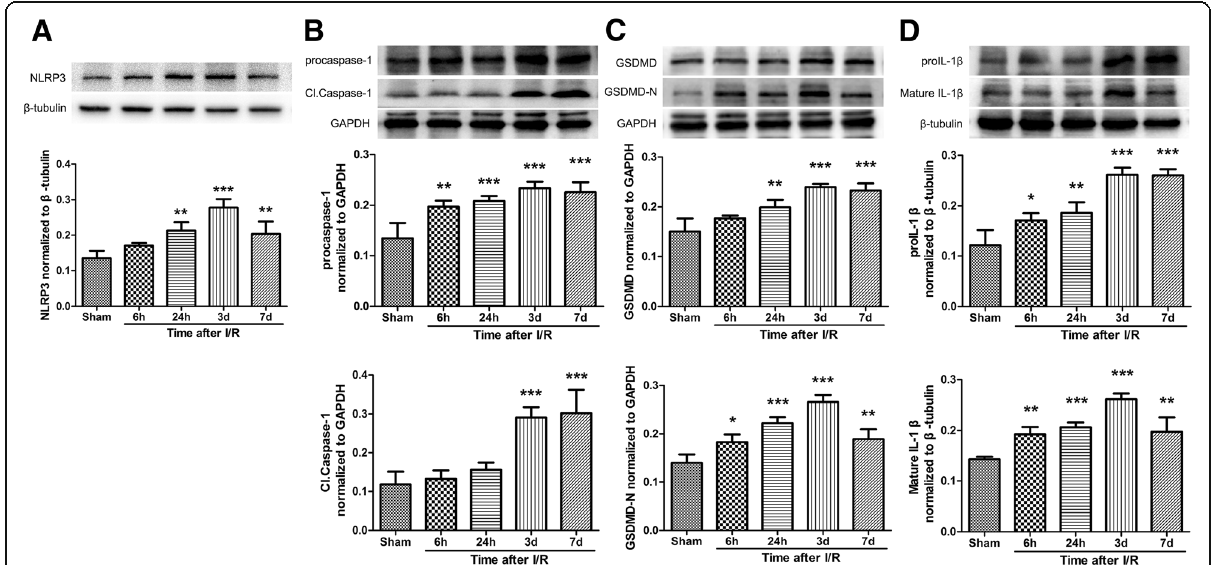
Fig. 2 Effect of cerebral ischemia-reperfusion injury on the expression of NLRP3 inflammasome. Representative western immunoblotting analysis of NLRP3 ( a ), Caspase-1 ( b ), GSDMD ( c ) and IL-1 β ( d ) ( n = 4). Cerebral ischemia/reperfusion injury significantly increased NLRP3 inflammasome levels such as NLRP3, procaspase-1, Cl.Caspase-1, GSDMD, GSDMD-N, proIL-1 β and mature IL-1 β . The contents showed the highest at 3 days after reperfusion. * P < 0.05, ** P < 0.01, *** P < 0.001 vs. Sham